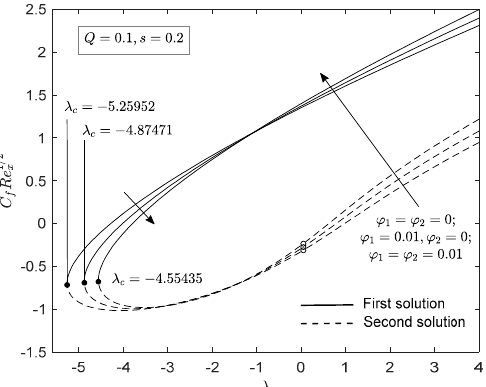
Figure 3 . Influence of SWCNT nanoparticle on θ ( η ) .